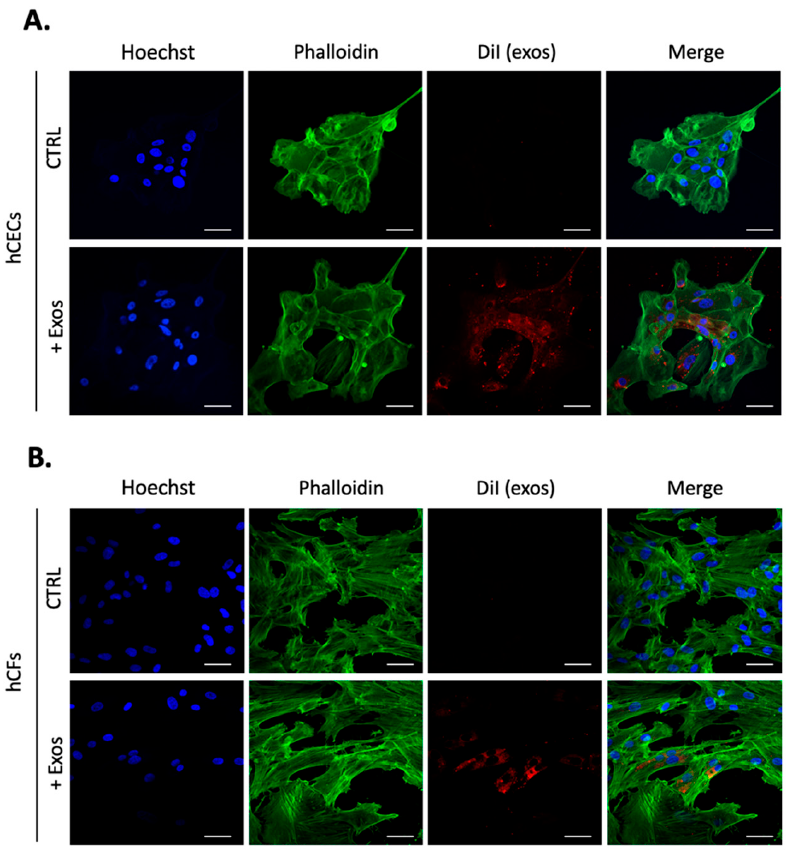
Figure 2. Exosomes uptake in hCECs and hCFs. Exosomes were labeled with the lipophilic dye, DiI. DiI-labeled exosomes were incubated (direct addition to the culture medium) with either hCECs or hCFs for 24 h prior to fixation and immunofluorescence staining. HBS, which was used to resuspend exosomes, was used as control (CTRL). Cells were stained with phalloidin, which exhibits green fluorescence, diI-labeled exosomes appeared in red and nuclei (Hoechst staining of DNA) in blue. Panels ( A ) and ( B ) show representative images of diI-labeled exosomes uptake by hCECs and hCFs, respectively. Scale bars: 50 μ m.